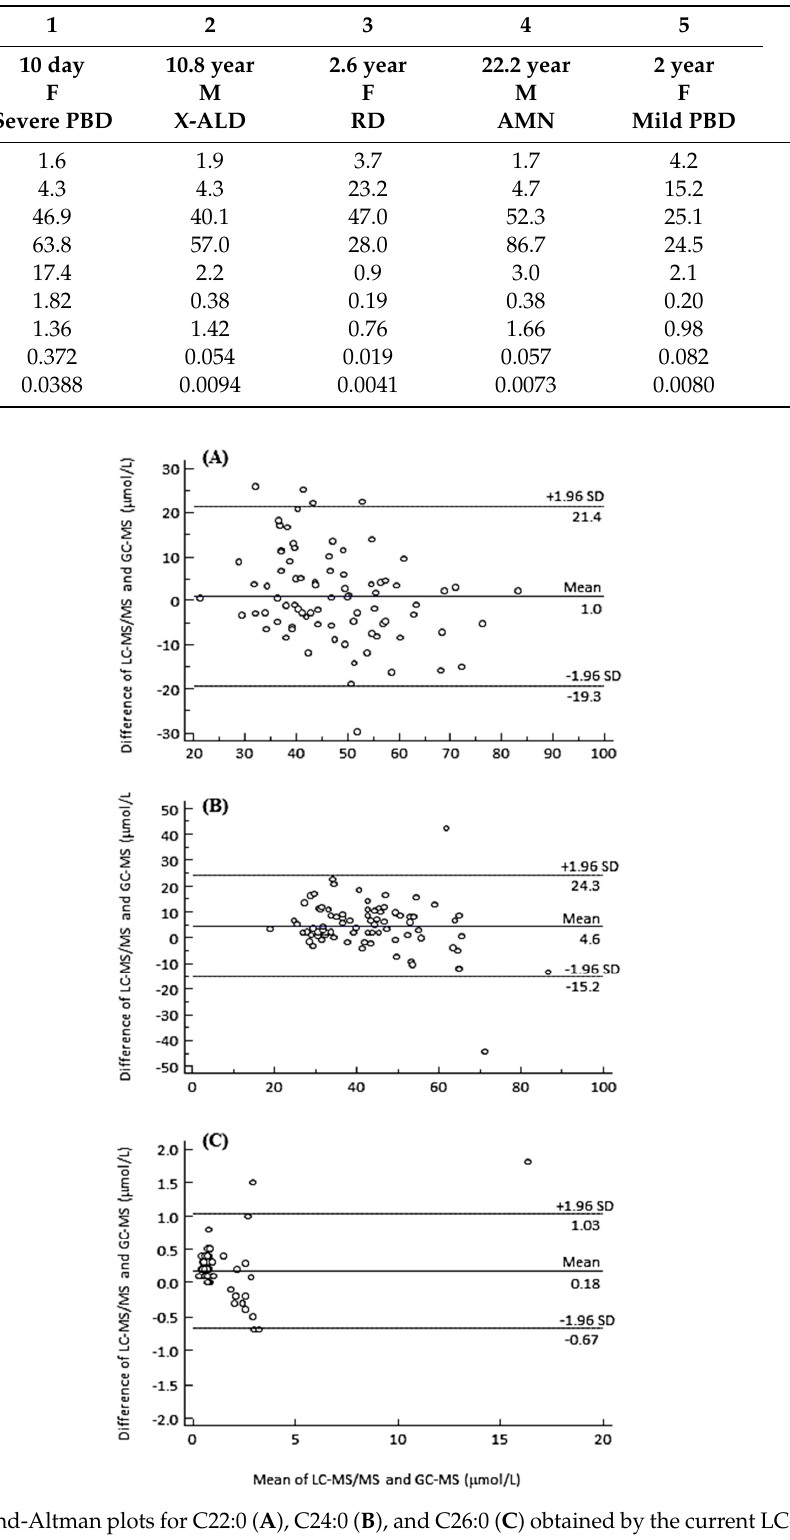
Table 4. Concentrations of relevant FAs in patients with peroxisomal disorders ( µ mol / L).